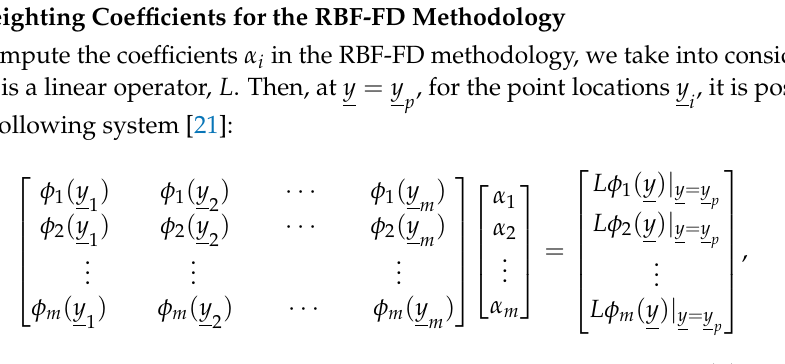
Figure 1. Distributions of the nodes along each spatial variables, for m = n = o = 10 at the top and m = m = o = 30 at the